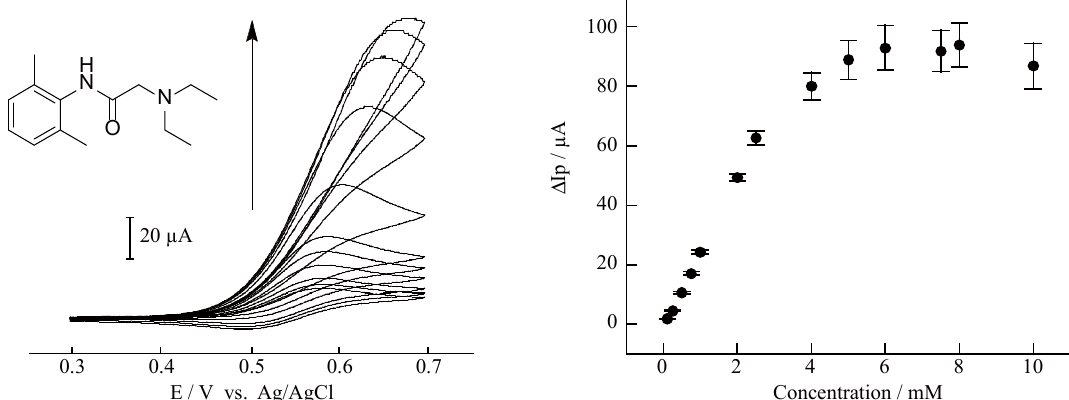
Figure 7. Cyclic voltammograms of NNO (1 mM) in the absence and presence of 0.1, 0.25, 0.5, 0.75, 1, 2, 4, 6, 8, and 10 mM lidocaine in 100 mM phosphate buffer solution (pH 7.4). Scan rate was 100 mV s − 1 (left). Anodic peak current in cyclic voltammograms of NNO was a function of the concentration of lidocaine in 100 mM phosphate buffer (pH 7.4). Average values of three electrodes with standard deviation are plotted (right).